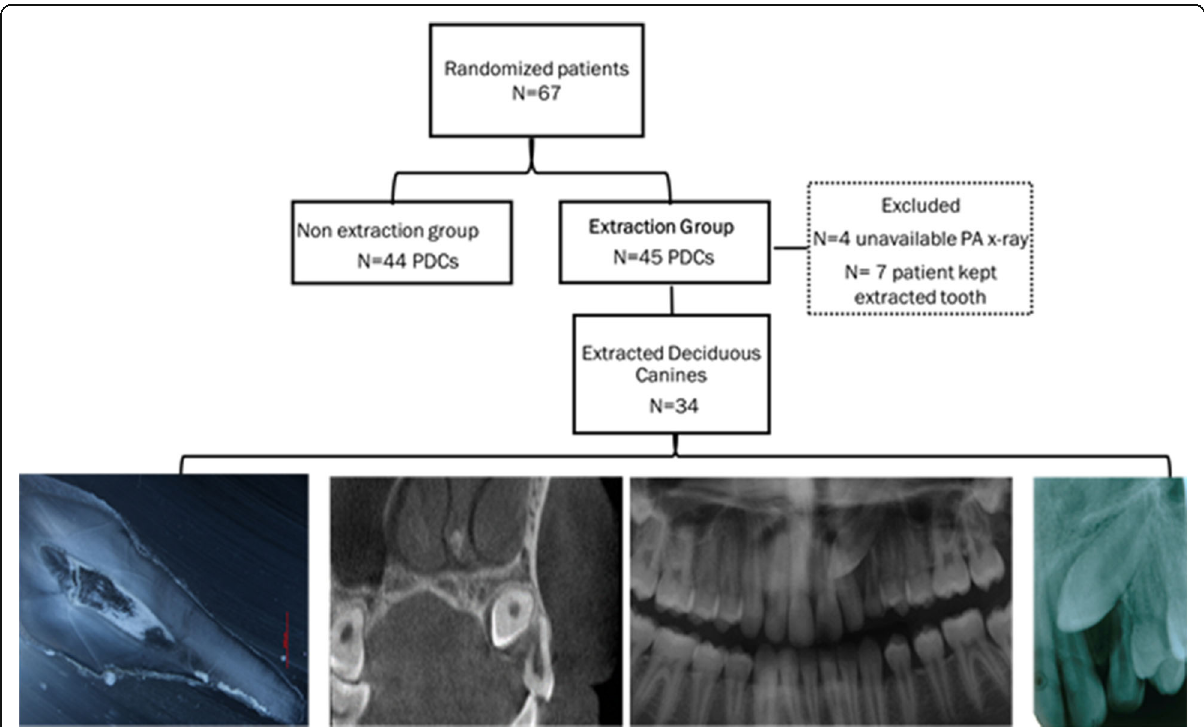
Fig. 1 Flow chart describing the study material. N = amount of patients, PDCs = palatally displaced canines, PA = periapical